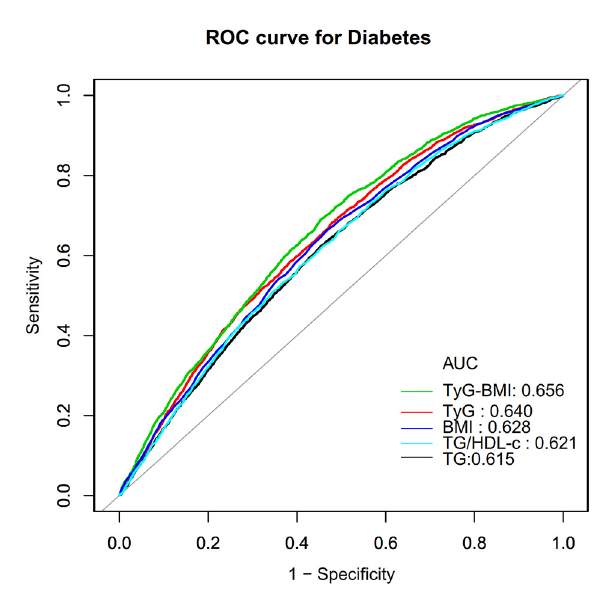
FIGURE7 The results of ROC curve analysis for measuring the ability of TyG-BMI, BMI, TG, TyG, and TG/HDL-c ratio to predict the risk of